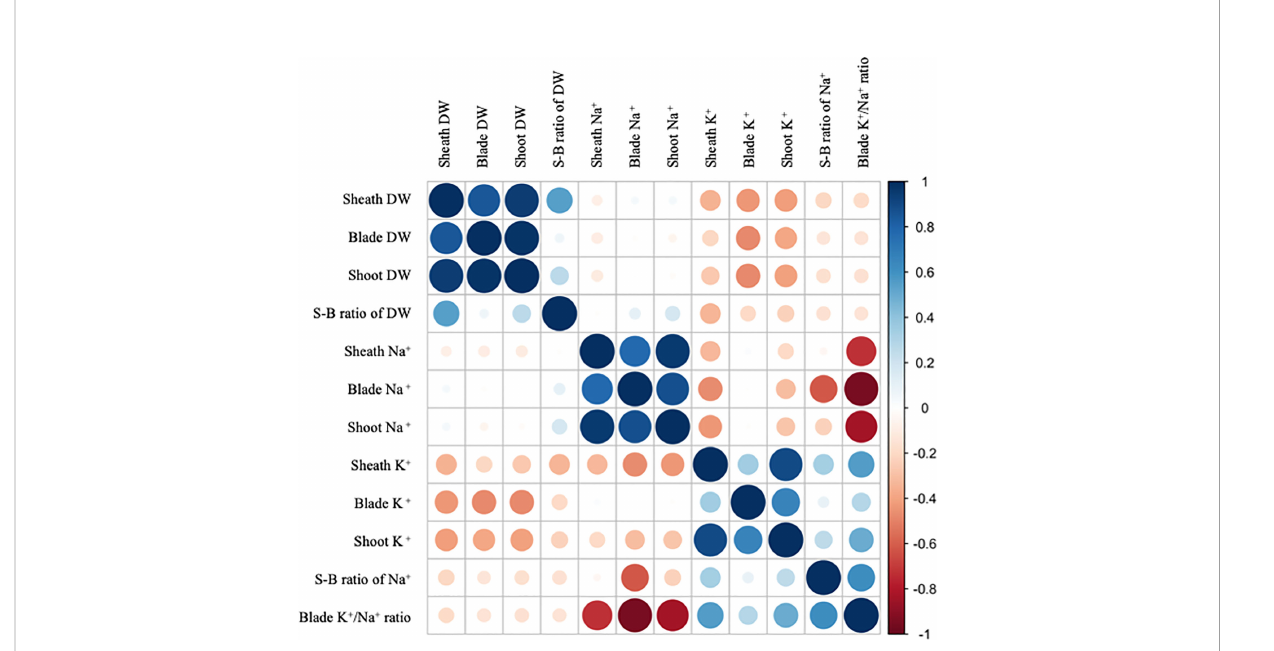
FIGURE 3 Correlations of phenotypes. Colors of dots indicate the Spearman correlation coef fi cients among traits in F 2 families at seedling stage in the presence of 30 mM NaCl in hydroponics imposed for one week corresponding to the bar on the right. S-B ratio: Sheath-blade ratio.